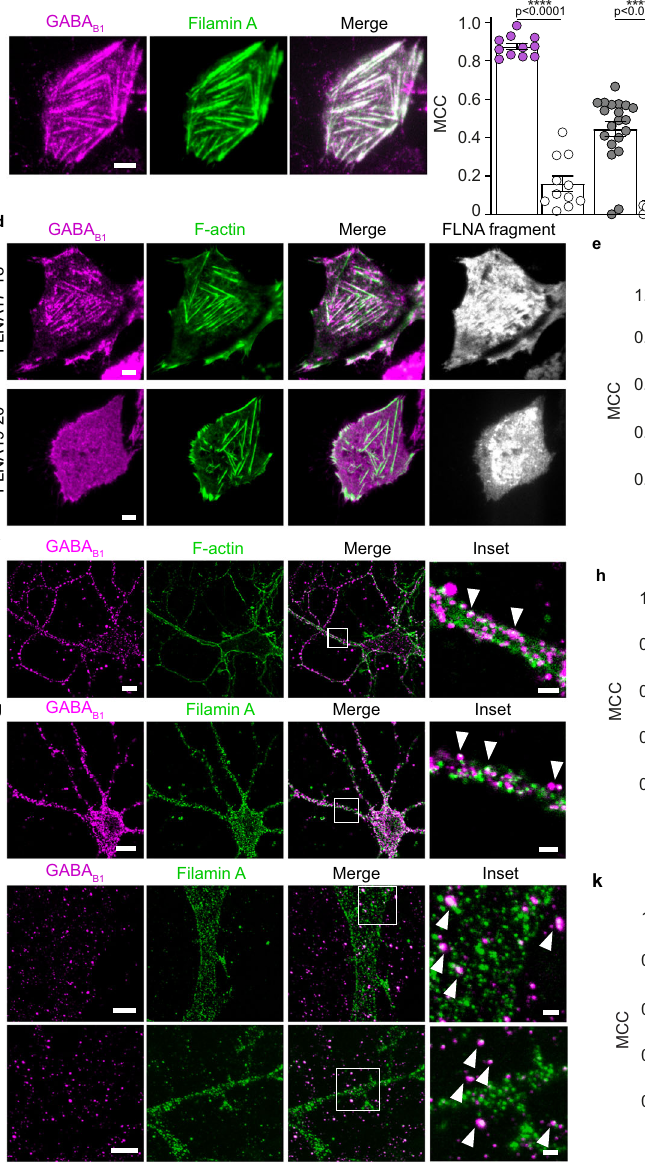
Fig.2|FLNAmediatesGABA B receptorassociationwiththeactincytoskeleton. a Representative TIRF images of CHO cells transfected with SNAP-GABA B1 (magenta), GABA B2 and eGFP-FLNA (green) for 24h and labeled with SNAP-647. White color in the merge image is indicative of colocalization. b Quanti fi cation of GABA B and CD86 colocalization with FLNA. Shown are MCC values compared with those expected for homogenous distributions. Data are mean±SEM. n =11 and 20 cells(GABA B andCD86,respectively)examinedovertwoindependentexperiments. c Scheme of the FLNA dimer with each subunit composed of an N-terminal actin- binding domain attached to 24 immunoglobulin-like domains. d Representative TIRF images of CHO cells co-transfected with SNAP-GABA B1 and Lifeact-GFP and either DsRed-FLNA17-18 or DsRed-FLNA19-20. e Quanti fi cation of the effect of FLNA19-20onthecolocalizationbetweenSNAP-GABA B1 andLifeact-GFP.Shownare MCC values vs. those of homogenous GABA B1 distributions. Data are mean±SEM. n =29 and 32 cells (FLNA17-18 and FLNA19-20, respectively) examined over three independent experiments. f , g Representative confocal microscopy images of